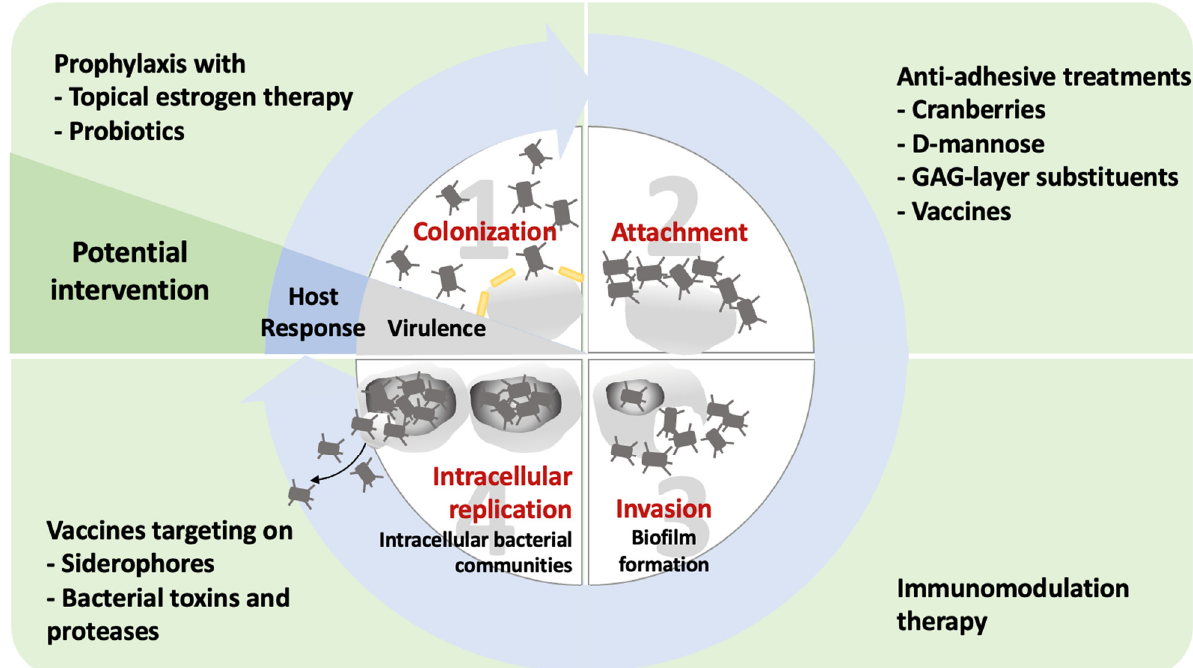
Figure 2. Potential antivirulence intervention for uropathogenic Escherichia coli . Schematic diagram illustrating alternative treatment options, including prophylactic strategies, antiadhesive treatments, immunomodulation therapy, and potential vaccines, that target the virulence of uropathogenic Escherichia coli.